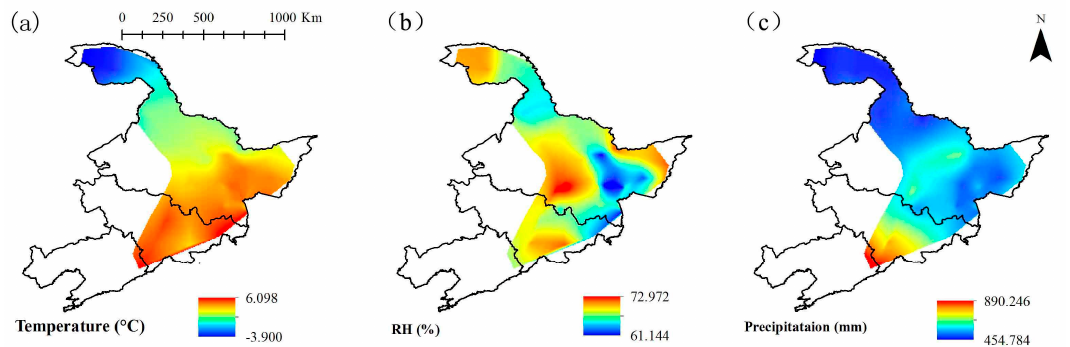
Figure 2. Spatial distributions of climatic factors of temperature ( a ), relative humidity (RH) ( b ) and precipitation ( c ) from 48 sampling plots for bark collection from white birch trees in Northeast